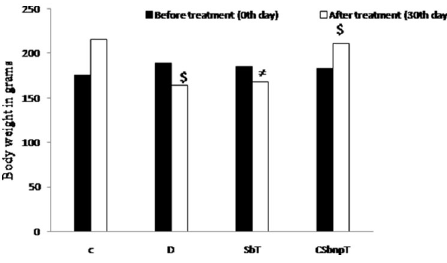
Figure 6. Effect of Sb and CSbnp treatment on body weight in rats. C – control group, D – diabetic group, SbT – Sb treated group, CSbnpT – CSbnp treated group. Results were expressed as mean 6 SD (n=6). ? P , 1.0 no significant difference compared with initial body weight. $ P , 0.05 significant difference when compared with initial body.